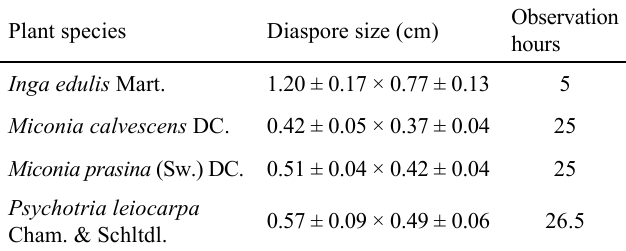
Table 1 . Plant species used in the removal-rate, destination and removal-distance experiments. Observation hours refer to the total time of removal-distance experiments.